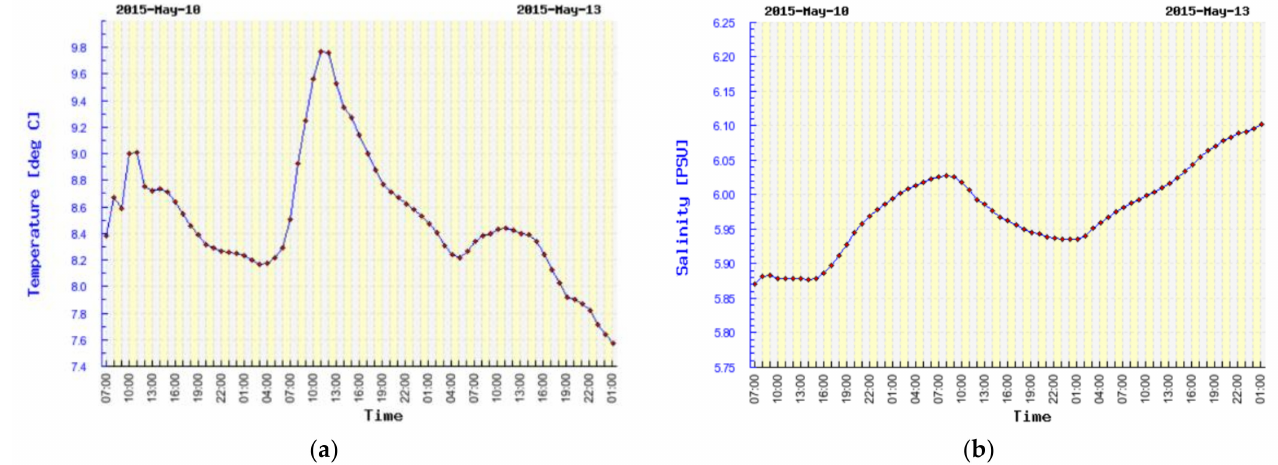
Figure 5. Temperature ( a ) and salinity ( b ) recorded in the station in Gda´nsk Northern Port in the Motława River for measurements in the Motława River.